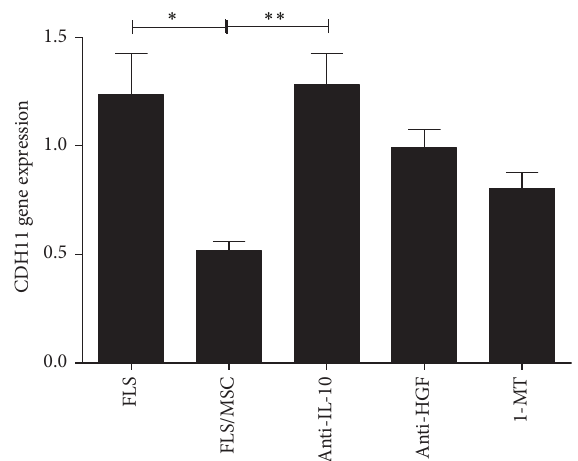
Figure 4: Suppression of soluble factors prevented the inhibitory effect of UCMSC on CDH11 expression by FLS from RA patients. Expression of CDH11 by FLS from RA patients, cocultured with UCMSC in the presence of anti-IL-10, anti-HGF antibody, or 1-MT. MSC: mesenchymal stem cells; FLS: fibroblast-like synoviocytes; CDH11: cadherin-11. ∗ 𝑃 < 0.05 ; ∗∗ 𝑃 < 0.01